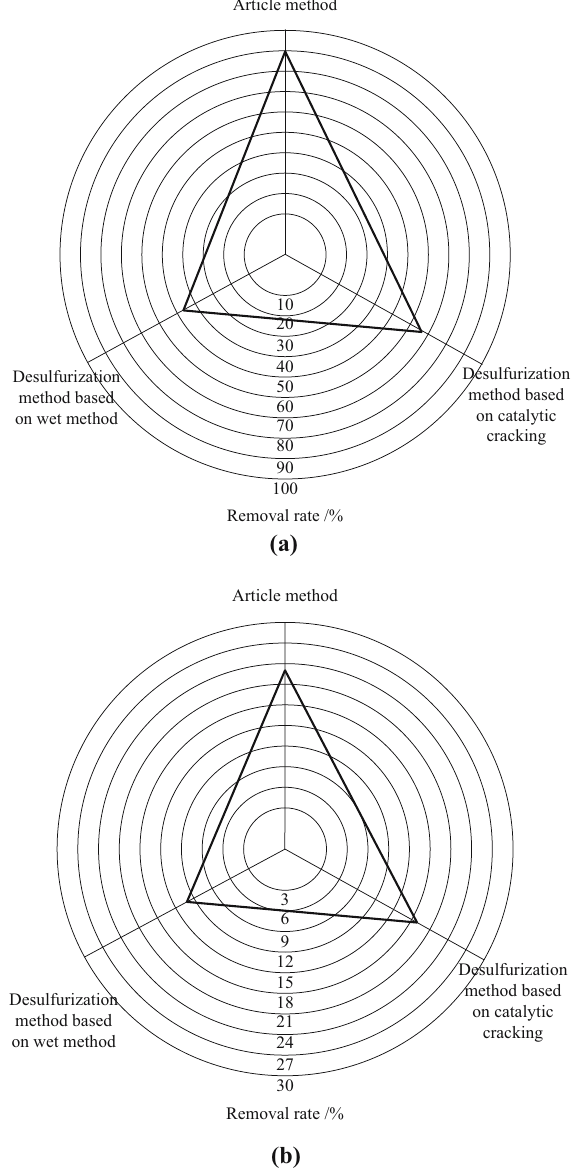
Figure 6: E ff ect comparisons of di ff erent methods. ( a ) Desul - furization e ff ect. ( b ) Denitration e ff